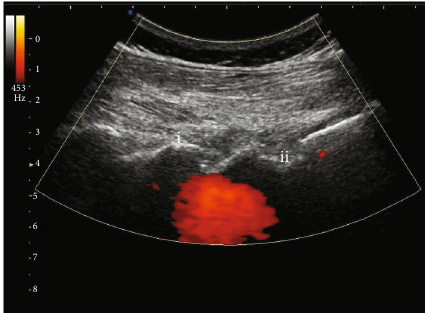
Figure 2: Ultrasound-guided transforaminal injection in out-of-plane approach. Ultrasound-guided transforaminal injection was performed, and the needle tip was positioned in the middle of (i) L5/S1 facet joint and (ii) sacral foramina. The red signal represented the spreading of drug in targeted epidural